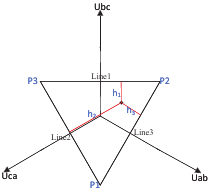
Figure 5. Triangle of class B.